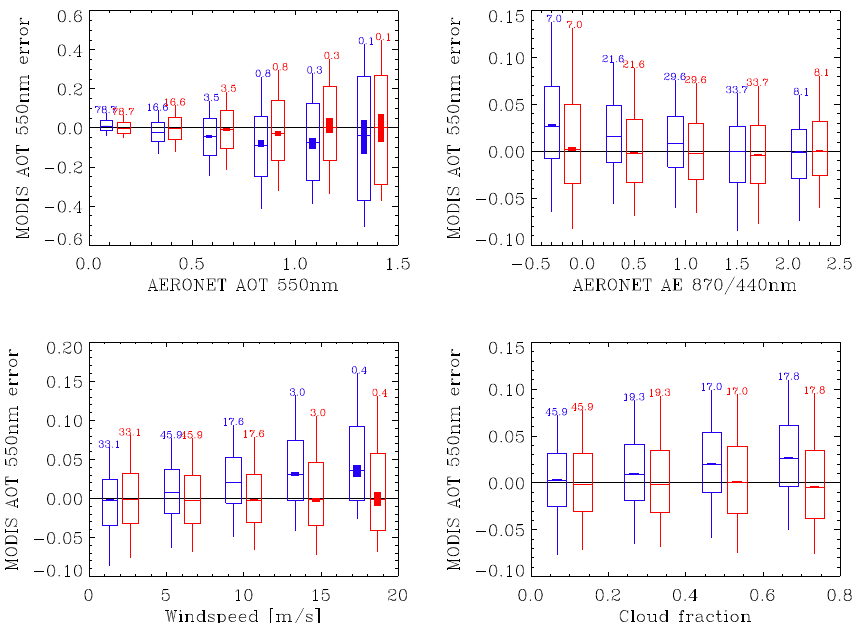
Fig. 8. MODIS Aqua AOT error statistics as a function of AERONET AOT, AERONET AE, NCEP-DOE-II wind speed and MODIS cloud fraction for the original (blue) and the corrected AOT (red). The box–whisker plots are offset from these bin centres to show the two distributions side by side. Numbers above the box and whisker show the percentage of the total sample used in that bin.